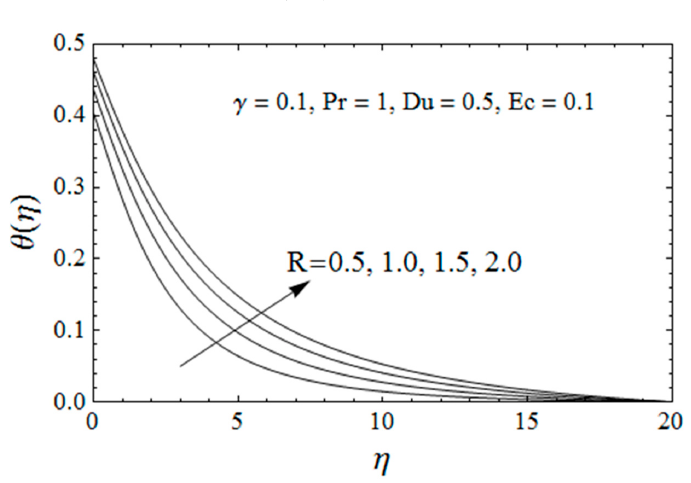
Figure 4. 𝜃(𝜂) for different 𝑅.